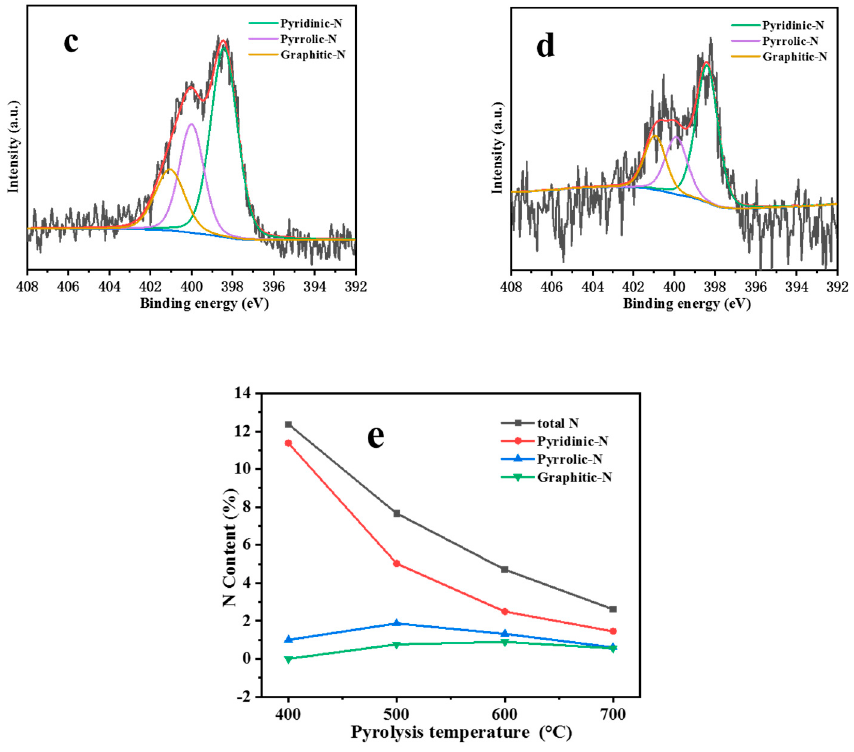
Figure 8. XPS analysis N 1s region of FeCo/NC-T catalysts ( a ) FeCo/NC-400; ( b ) FeCo/NC-500; ( c ) FeCo/NC-600; ( d ) FeCo/NC-700; and ( e ) N types and contents of catalysts.